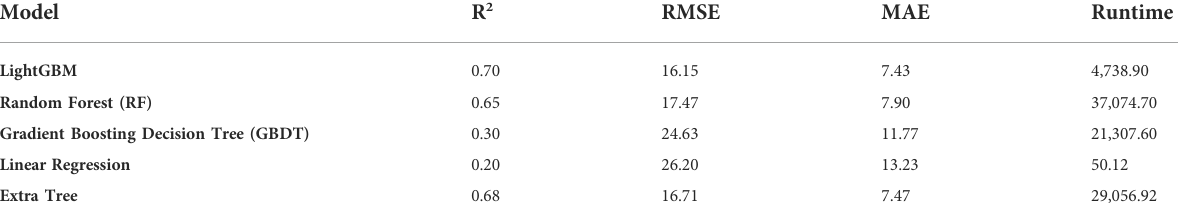
TABLE 4 Performances Comparisons of Machine Models in Himawari-8 TOAR data.